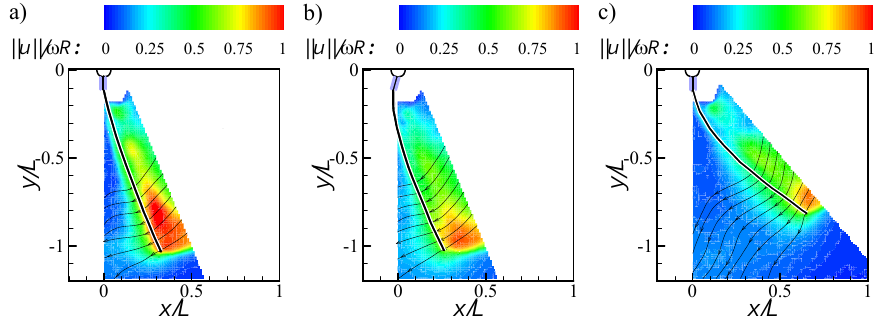
Figure 5. Phase-locked distributions of the velocity magnitude with superimposed streamlines in the vicinity of the thick plate at: ( a ) ω = 60 rpm; ( b ) ω = 90 rpm; and ( c ) ω = 120 rpm.